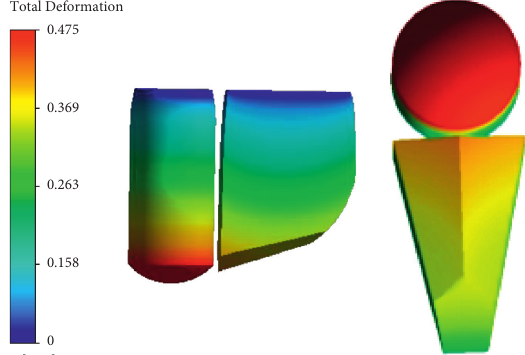
Figure 21: Deformation contour of thermowell and interference